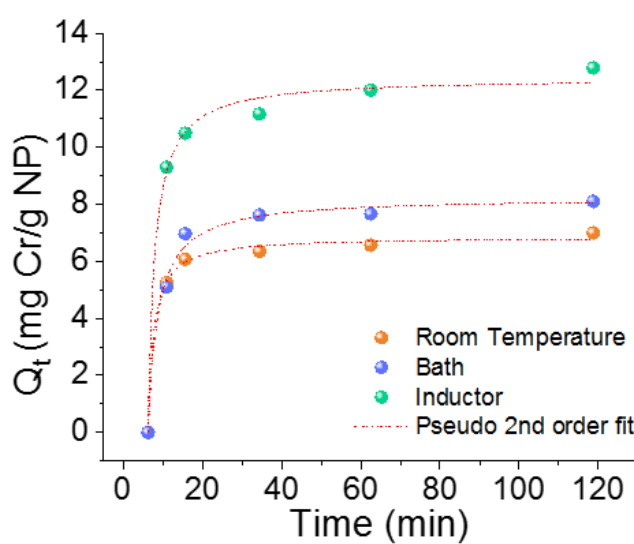
Figure 5. Time dependence of adsorption capacity of Cr(VI) ions onto NPs at room temperature and at 60 °C, in thermal bath and in inductor conditions with a sorbent dose of 2 g/L.